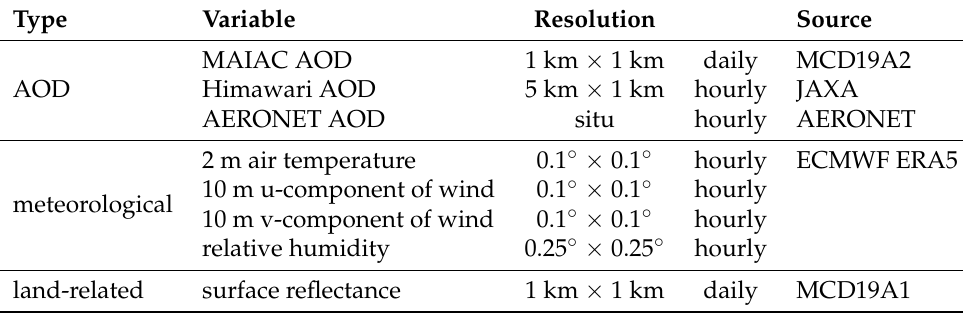
Table 2. Summary of the data sources used in this